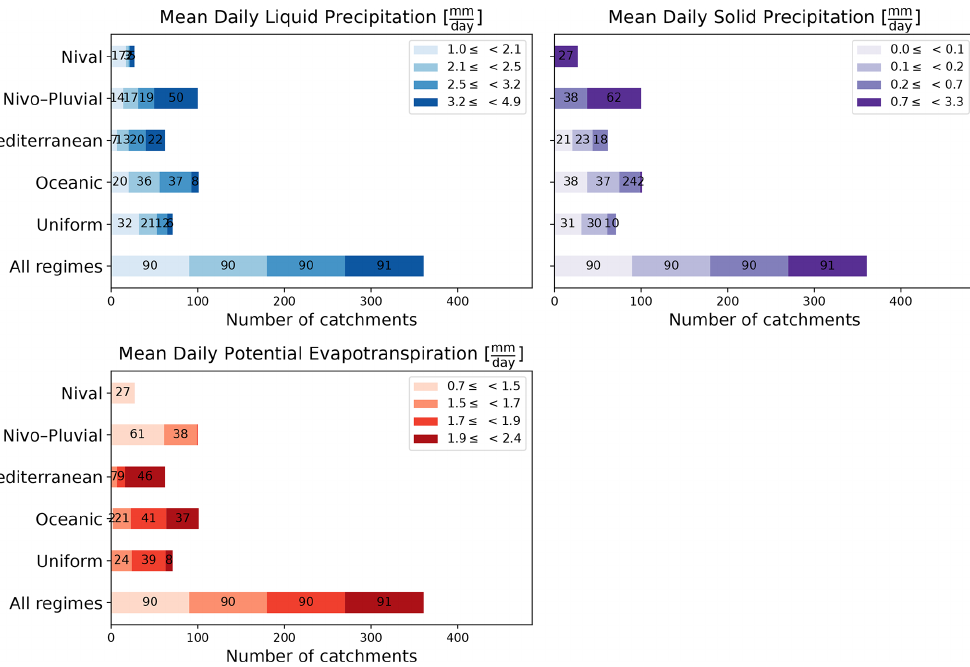
Figure 6. Stacked bar charts showing the variation in the three climatic attributes used in this paper within each regime and the entire sample. The end-to-end segments of each bar correspond to the intervals for each quartile of the climatic attribute of interest. The quartiles are computed by taking all 361 catchments into account. The number inside each segment denotes its